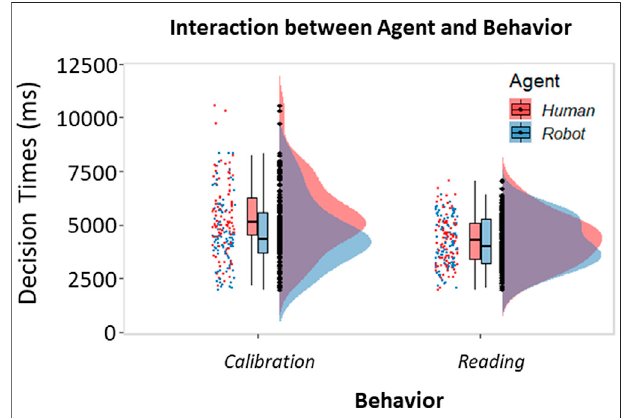
FIGURE 4 | Histograms and raincloud plots showing the two-way interaction between Agent and Behavior (GLM). Boxplots associated with the raincloud plots depict median values (black horizontal lines), interquartile ranges(blackboxes),andupper-lowerquartileintervals(blackwhiskers).